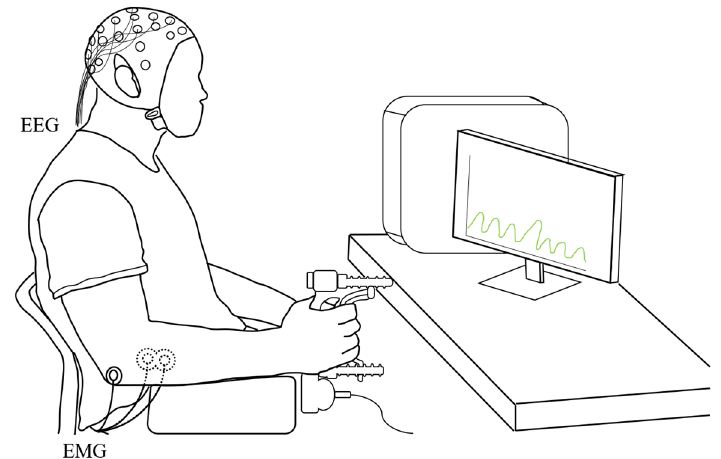
Figure 1. Experimental setup and posture of the participants.